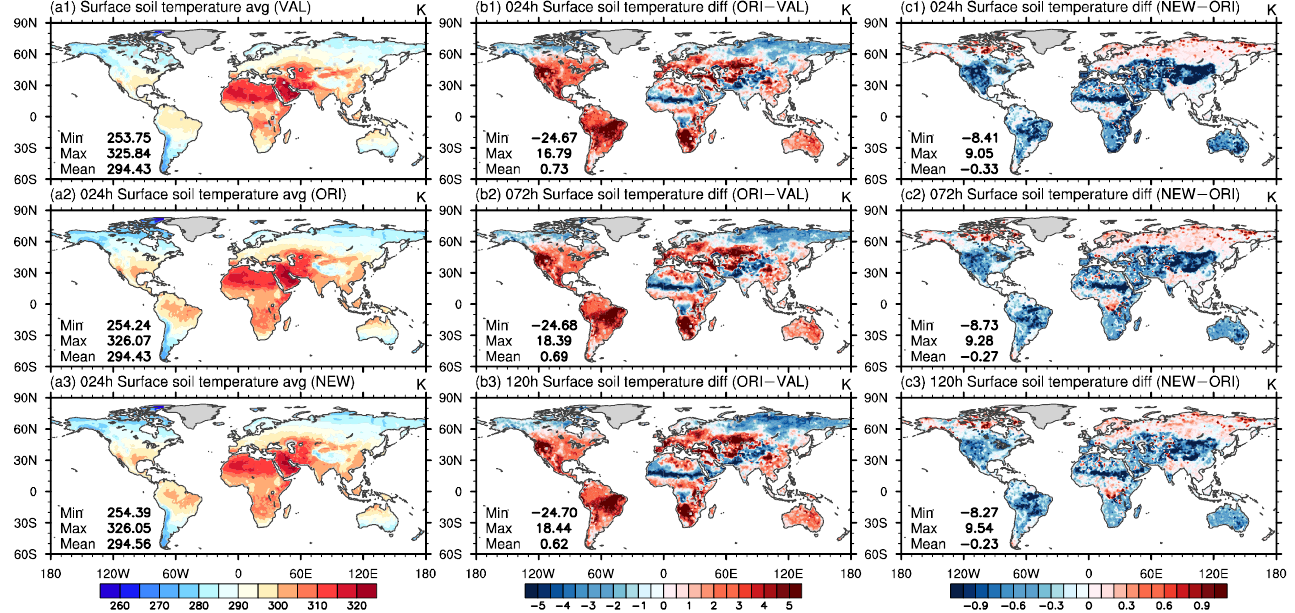
Figure 10. Same as Figure 9, but for surface soil temperature (Units: K).